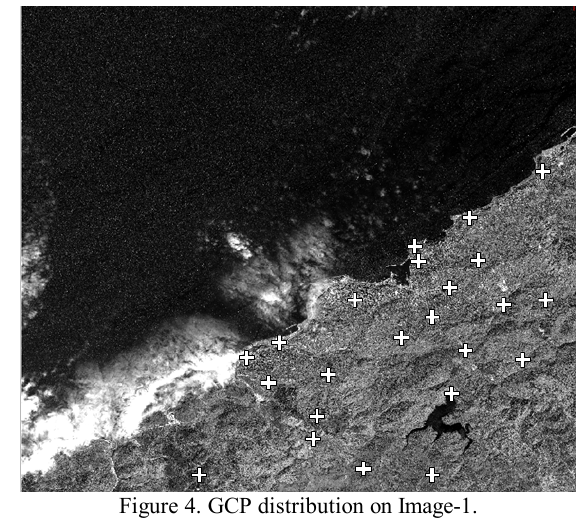
Figure 4. GCP distribution on Image-1.